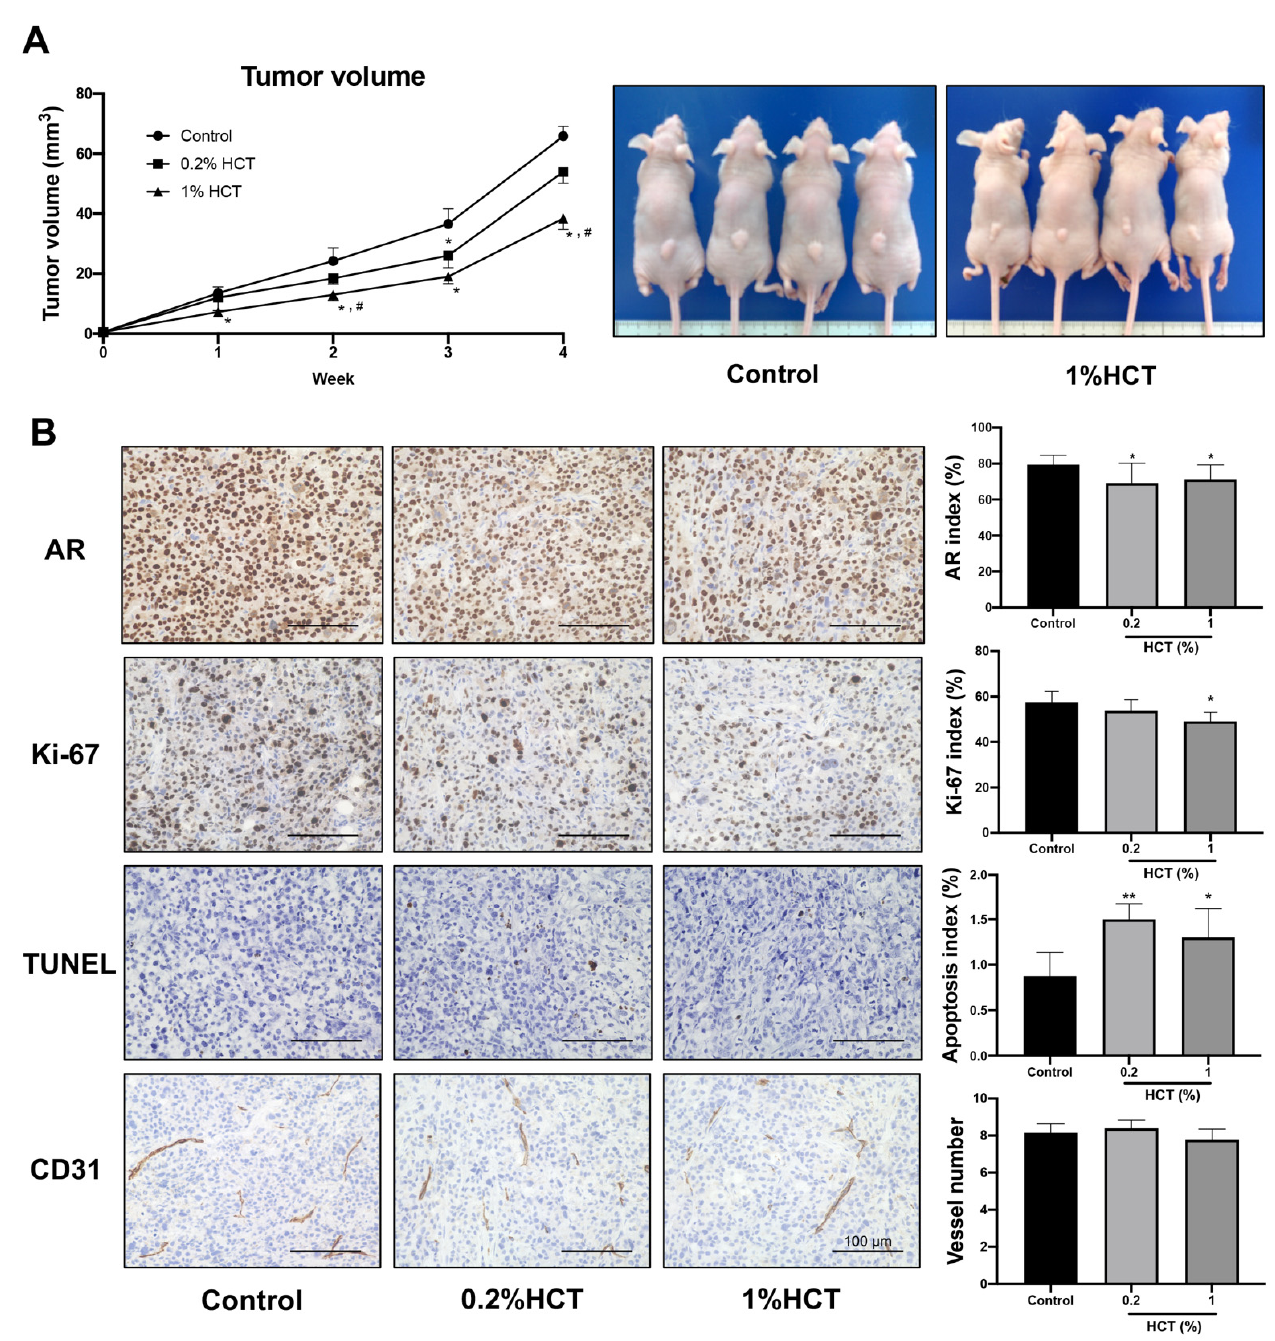
Figure 9. Effect of HCT on castration-resistant prostate cancer in the PCai1 xenograft model. Tumor volume of PCai1 xenograft mice that received control diet or HCT mixed diet ( A ). Representative images of immunohistochemistry for androgen receptor (AR), Ki-67, terminal deoxynucleotidyl transferase dUTP nick end labeling (TUNEL) assay, and the blood vessel marker, CD31, in PCai1 tumor ( B ). Data in bar graphs represent mean ± SD. * p < 0.05, ** p < 0.01 vs. control group. # p < 0.05 vs. 0.2% HCT group. HCT, Houttuynia cordata Thunb.